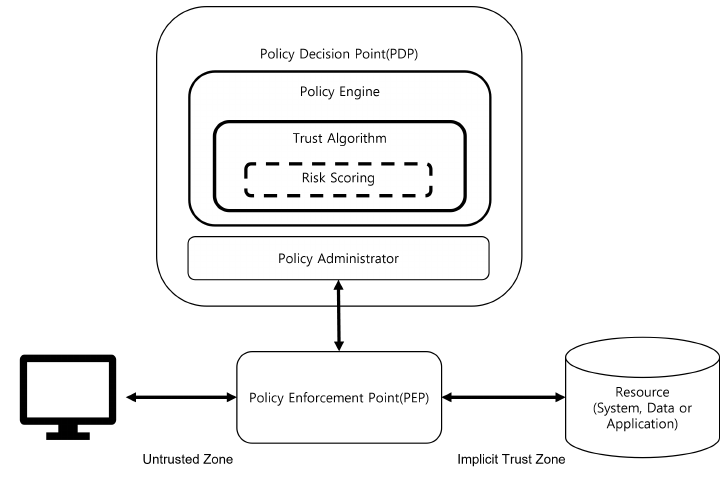
Figure 3. Risk Scoring in Zero